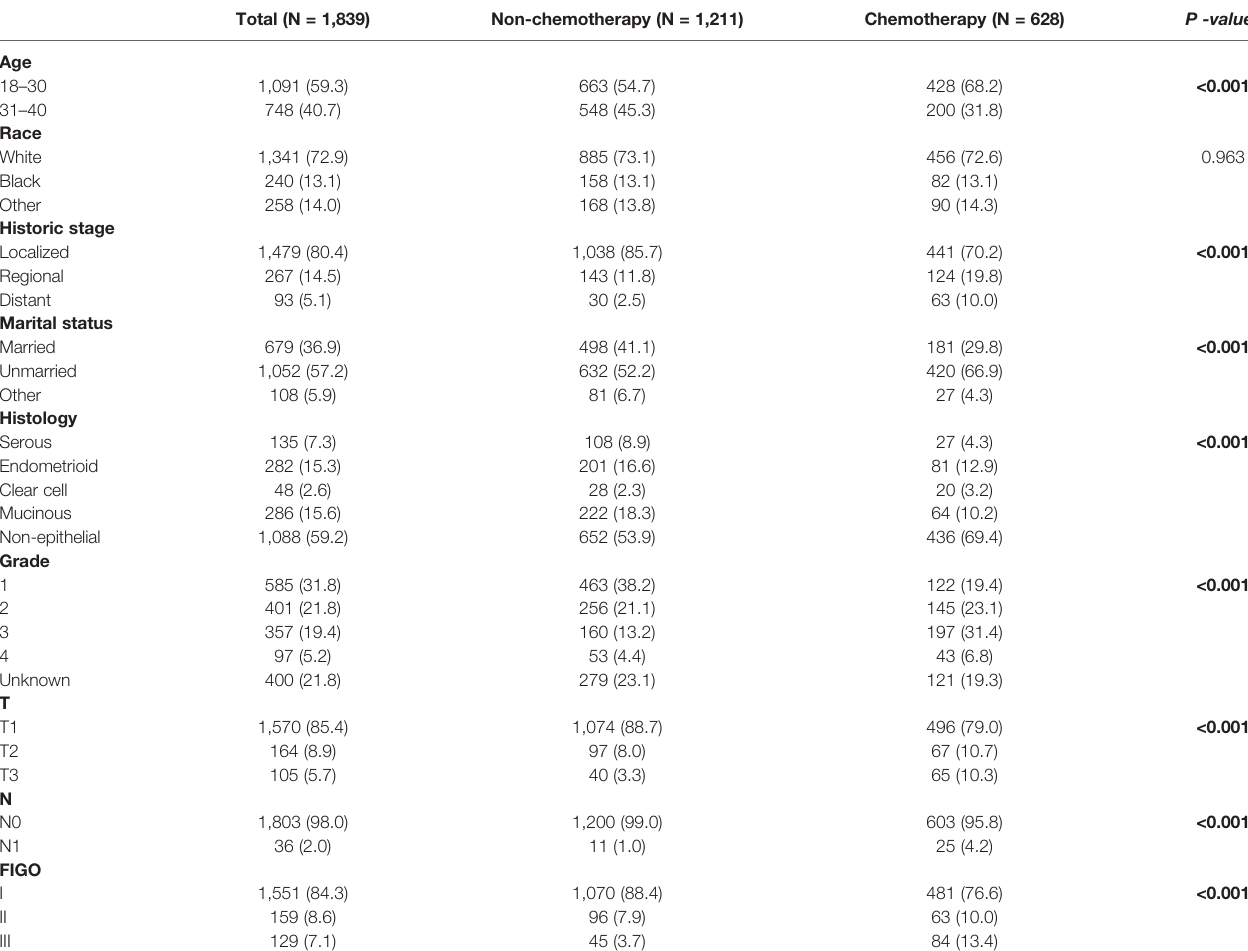
TABLE 1 | Baseline characteristics of women with